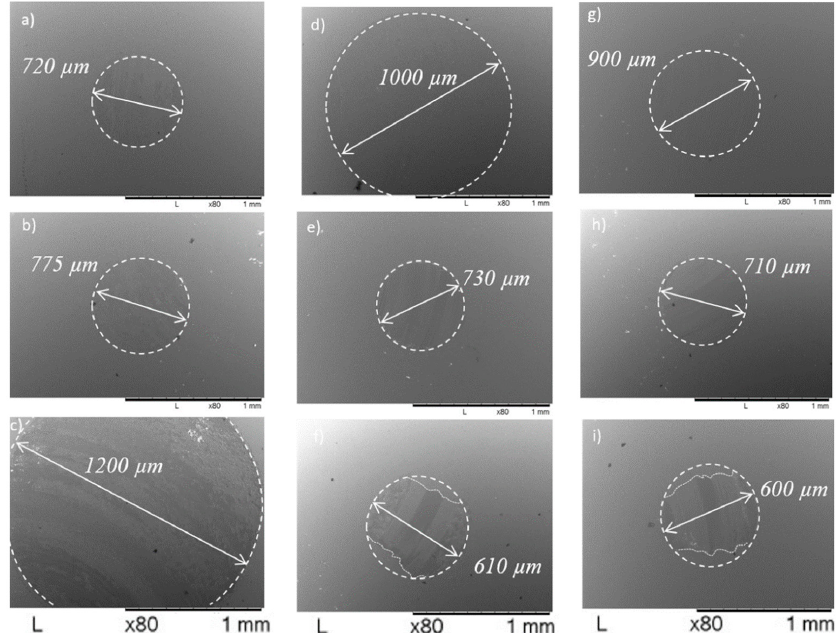
Figure 8. SEM images of the worn surface on the balls after sliding tests against the NCD film at ( a ) RT, ( b ) 300 °C and ( d ) 450 °C; Al 2 O 3 /NCD film at ( d ) RT, ( e ) 300 °C and ( f ) 450 °C; and A-Al 2 O 3 /NCD film at ( g ) RT, ( h ) 300 °C and ( i ) 450 °C.